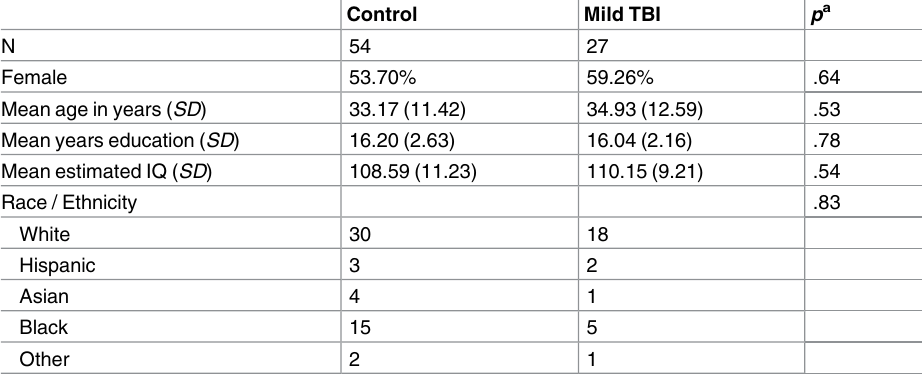
Table 1. Participant Characteristics.